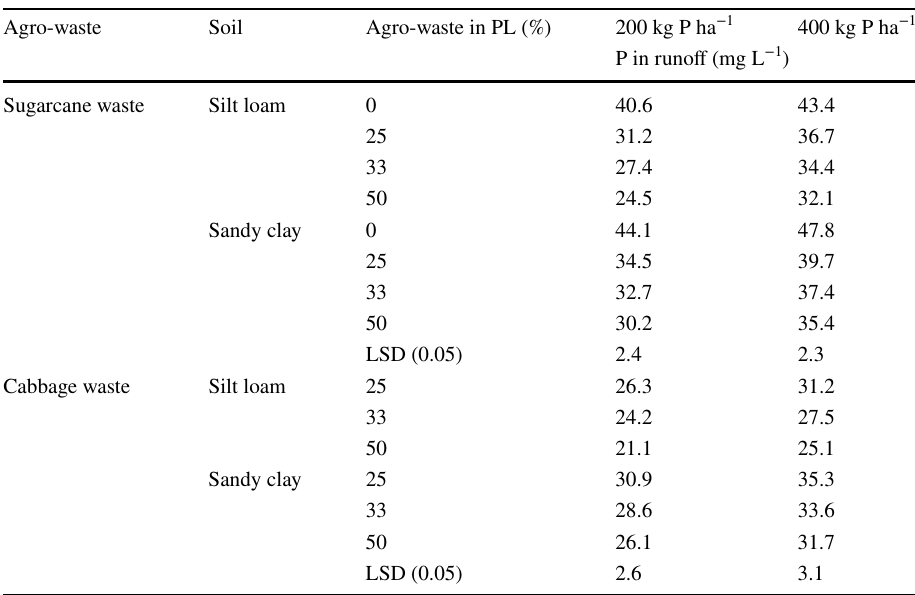
Table 4 Average phosphorus loss in runoff after two rainfall events from soils treated with co-composted poultry litter with agro-wastes at two application